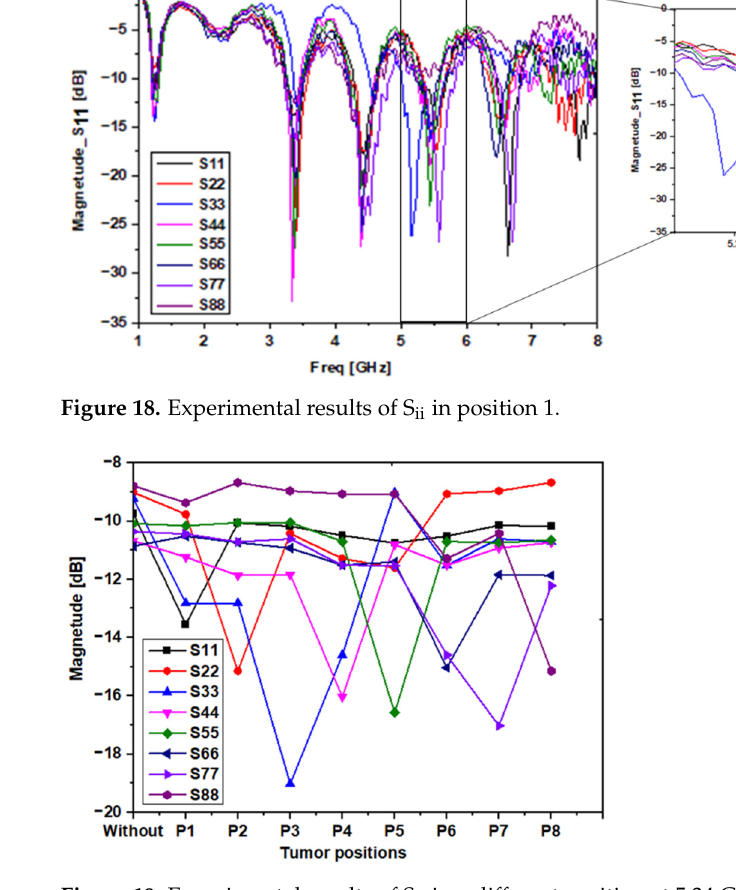
Figure 19. Experimental results of S ii in a different position at 5.34 GHz.